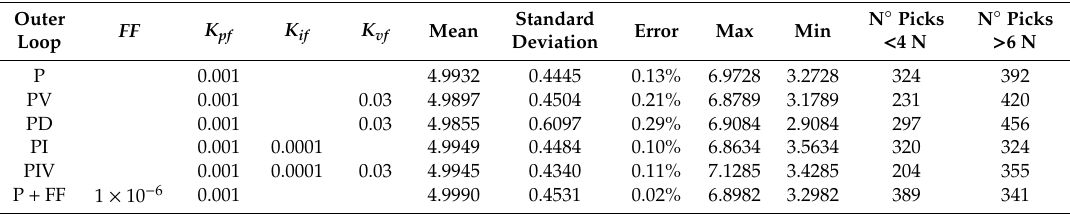
Table 6. Comparison of outer loops.